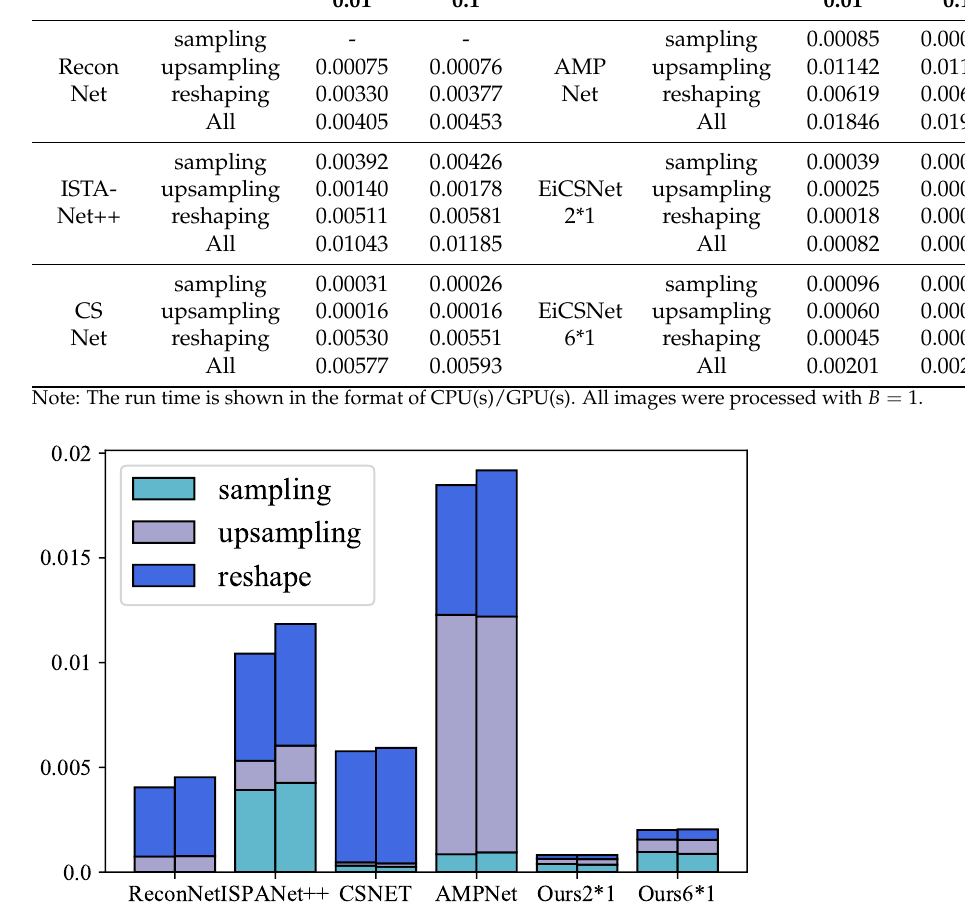
Figure 11. The time consumption of the sampling, upsampling, and reshaping of the different methods. All images were processed with B =